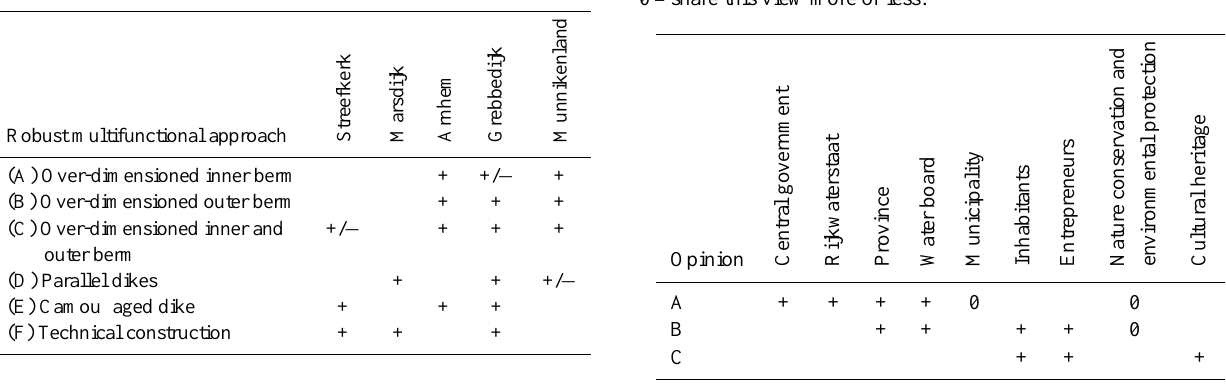
Table 8. The most appropriate approaches for the five locations. Refer back to Table 1 for an overview of the different approaches